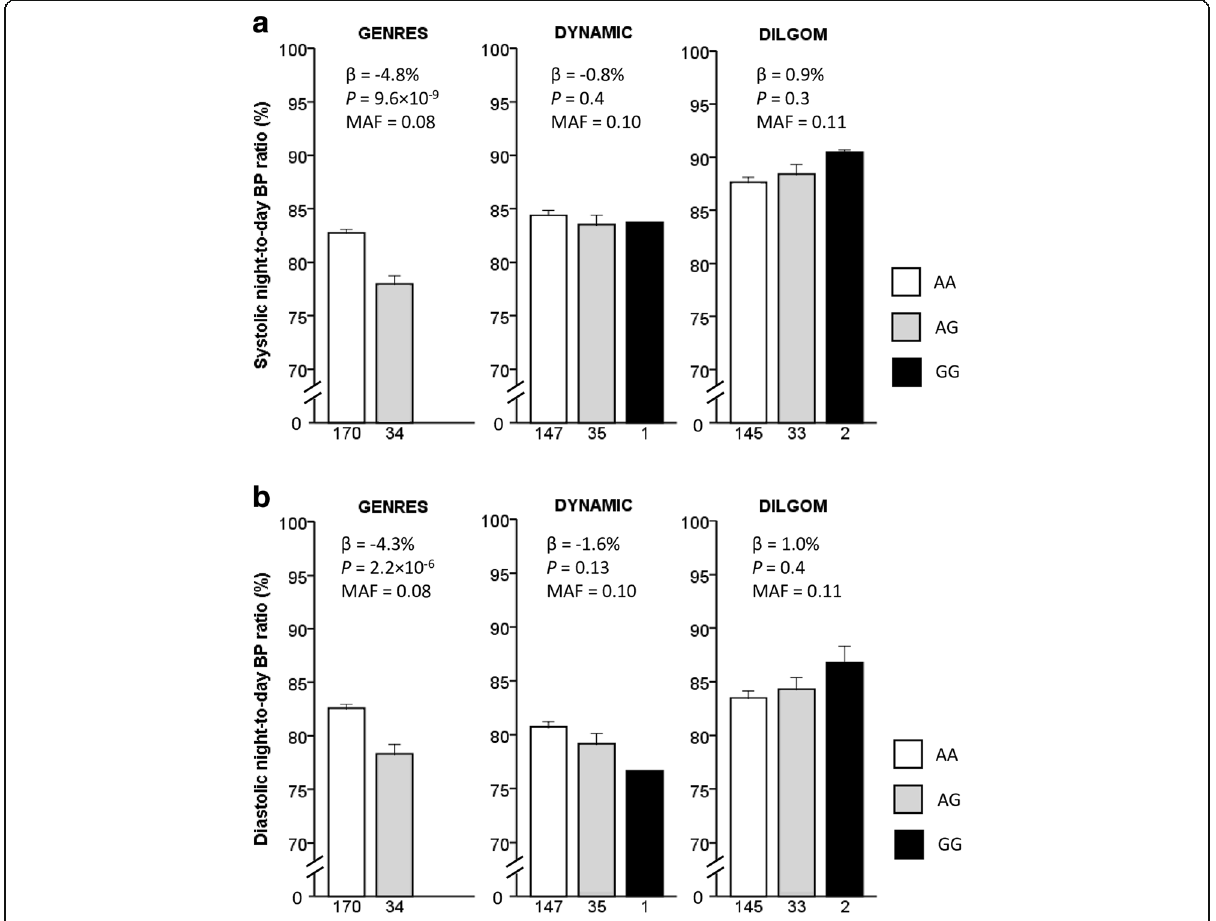
Fig. 2 Mean nocturnal blood pressure dipping according to rs4905794 genotypes in the three study samples. ( a ) SBP dipping (systolic night-to-day blood pressure ratio) ( b ) DBP dipping (diastolic night-to-day blood pressure ratio). Error bars indicate standard error of means. Abbreviations: SBP, systolic blood pressure; DBP, diastolic blood